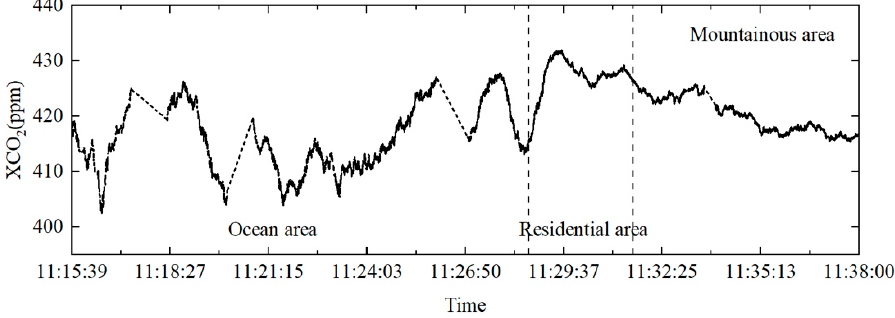
Figure 5. The XCO 2 results retrieved from IPDA measurements on 14 March 2019.